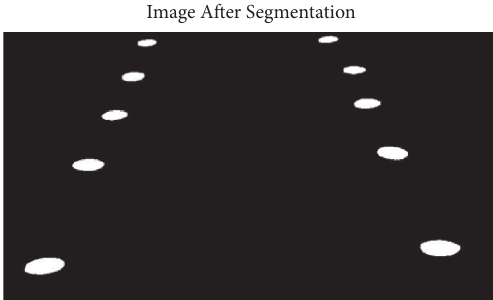
Figure 8: View after segmentation based on area and eccentricity